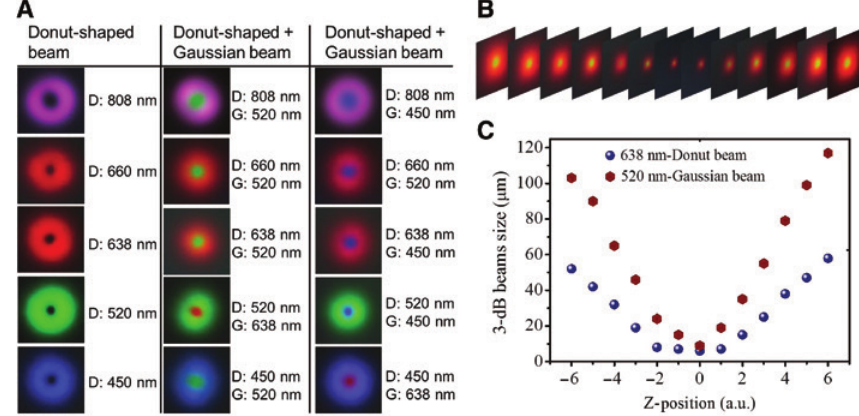
Figure 6: The characteristics of the multiplexed beams. (A) Intensity distribution of two color beams are multiplexed with flexible wavelengths. D and G refer to donut- and Gaussian-shaped beams, respectively. (B) Three-dimensional intensity distribution of donut/ Gaussian beams (638 nm/ 520 nm). (C) Beam sizes of the multiplexed beams at different positions before and after the focus of the lens.